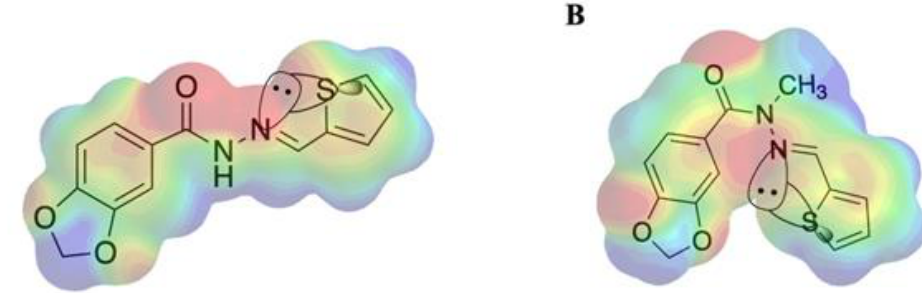
Figure 2. Representation of chalcogen interaction between the electron pair of the iminic nitrogen and the antibonding orbital in the thiophene ring. ( A ) Electrostatic potential map of LASSBio-294 ( 1 ); ( B ) Electrostatic potential map of LASSBio-785 ( 2 ). Red shadow represents the negatively charged area; blue shadow represents the positively charged area.